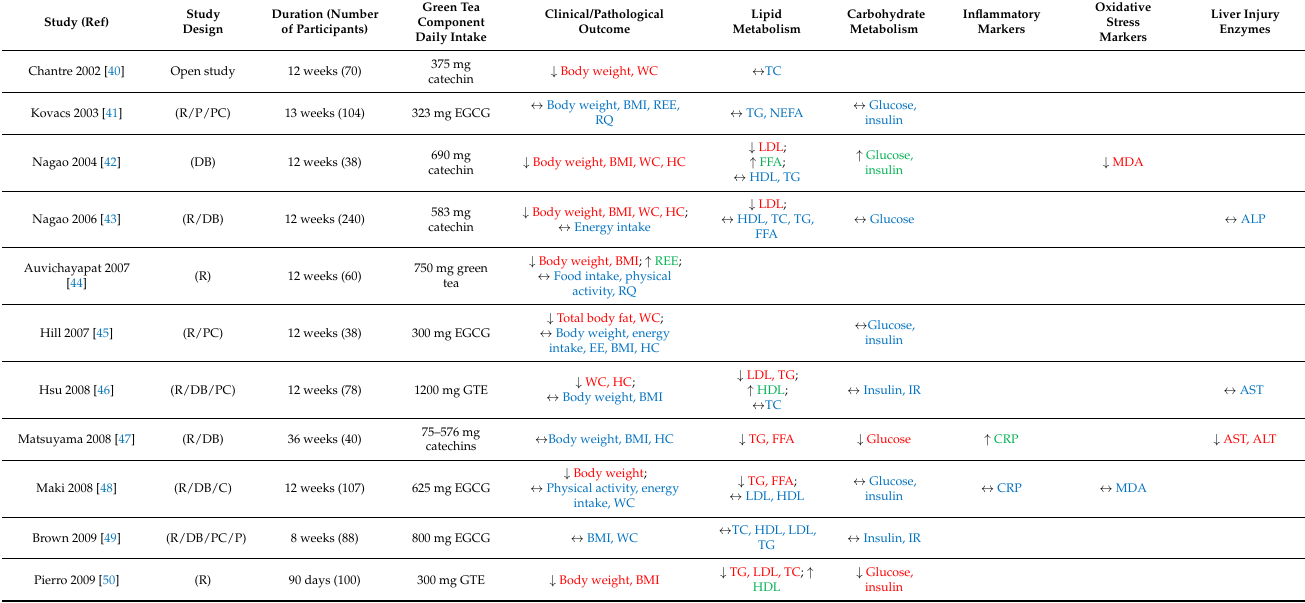
Figure 4. Oxidative stress and antioxidation pathways. Gray boxes represent pro-oxidation end- products. Brown boxes represent pro-oxidation molecules. Yellow boxes represent antioxidation molecules. Reducing the production of H 2 O 2 or increasing its breakdown will reduce the oxidant stress. EGCG appears to act via both mechanisms. The end result is reduced oxidative damage, as is evidenced by the reduced levels of MDA and 8-OHdG. Abbreviations: 8-OHdG: 8-hydroxy-2’- deoxyguanosine; CAT: catalase; CYP2E1: cytochrome-2E1; GSH: glutathione; MDA: malondialde- hyde; ROS: reactive oxidative species; SOD: superoxide dismutase. Table 2. Clinical Efficacy of Green Tea in Human